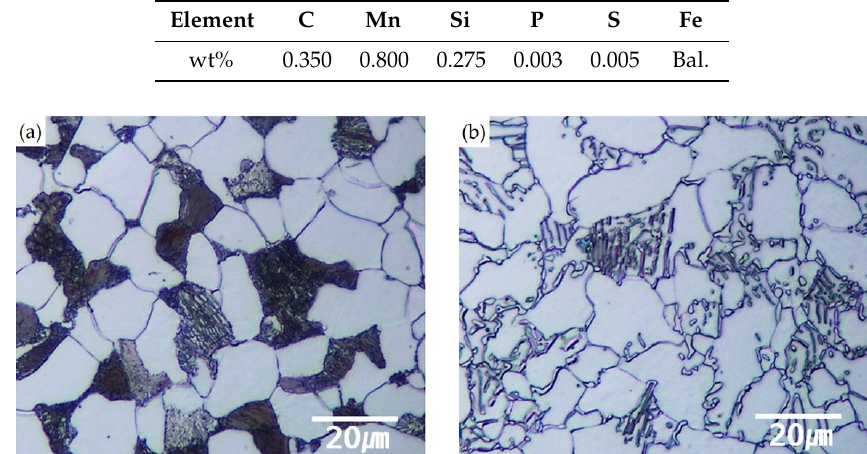
Figure 2. Microstructural changes (X500) of AISI 1035 cold drawn carbon steel by spheroidizing annealing at 760 °C for eight hours: ( a ) Microstructure before spheroidizing annealing (average grain size: 8.84 μm); ( b ) Microstructure after spheroidizing annealing (average grain size: 9.36 μm).